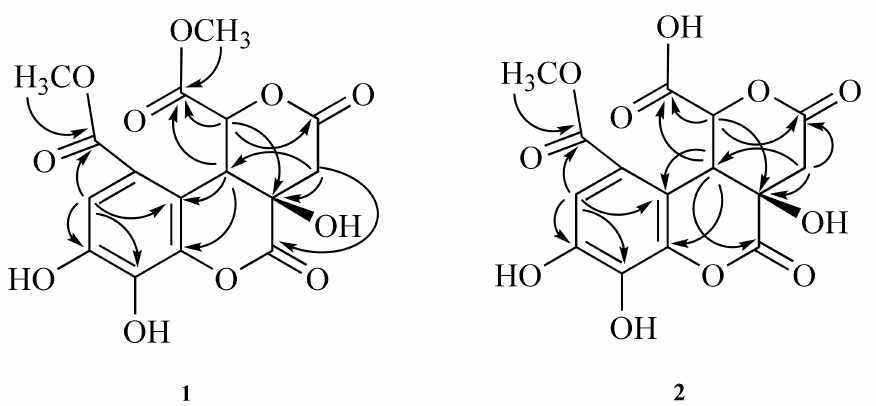
Figure 3. Key HMBC and COSY correlations of compounds 1 and 2 .